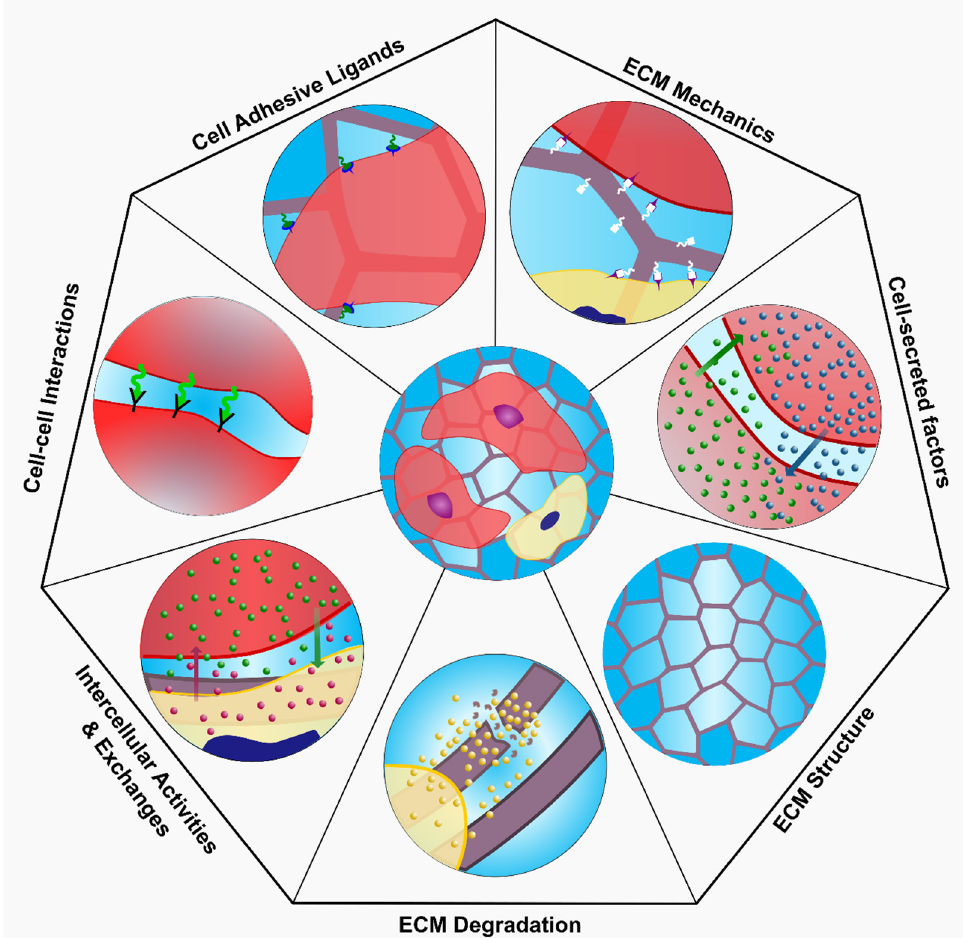
Figure 12. Schematic of interactions known to regulate stem cell fate within ECM